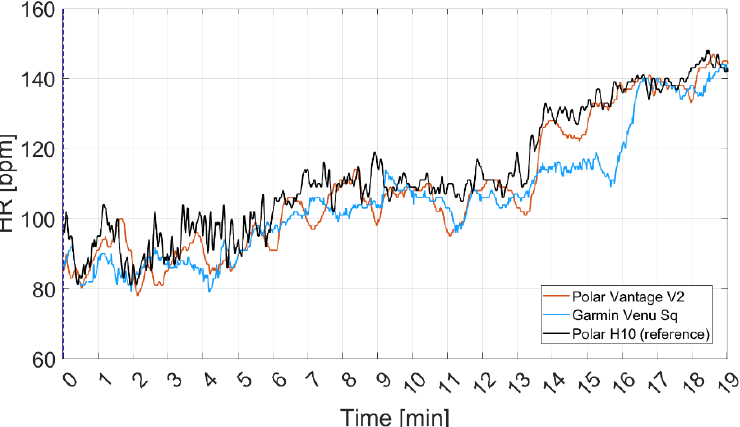
Figure 4. Example of the signals acquired through the two tested smartwatches (Garmin Venu Sq and Polar Vantage V2) and the reference device (Polar H10) in case of dry conditions. and Polar Vantage V2) and the reference device (Polar H10) in case of dry